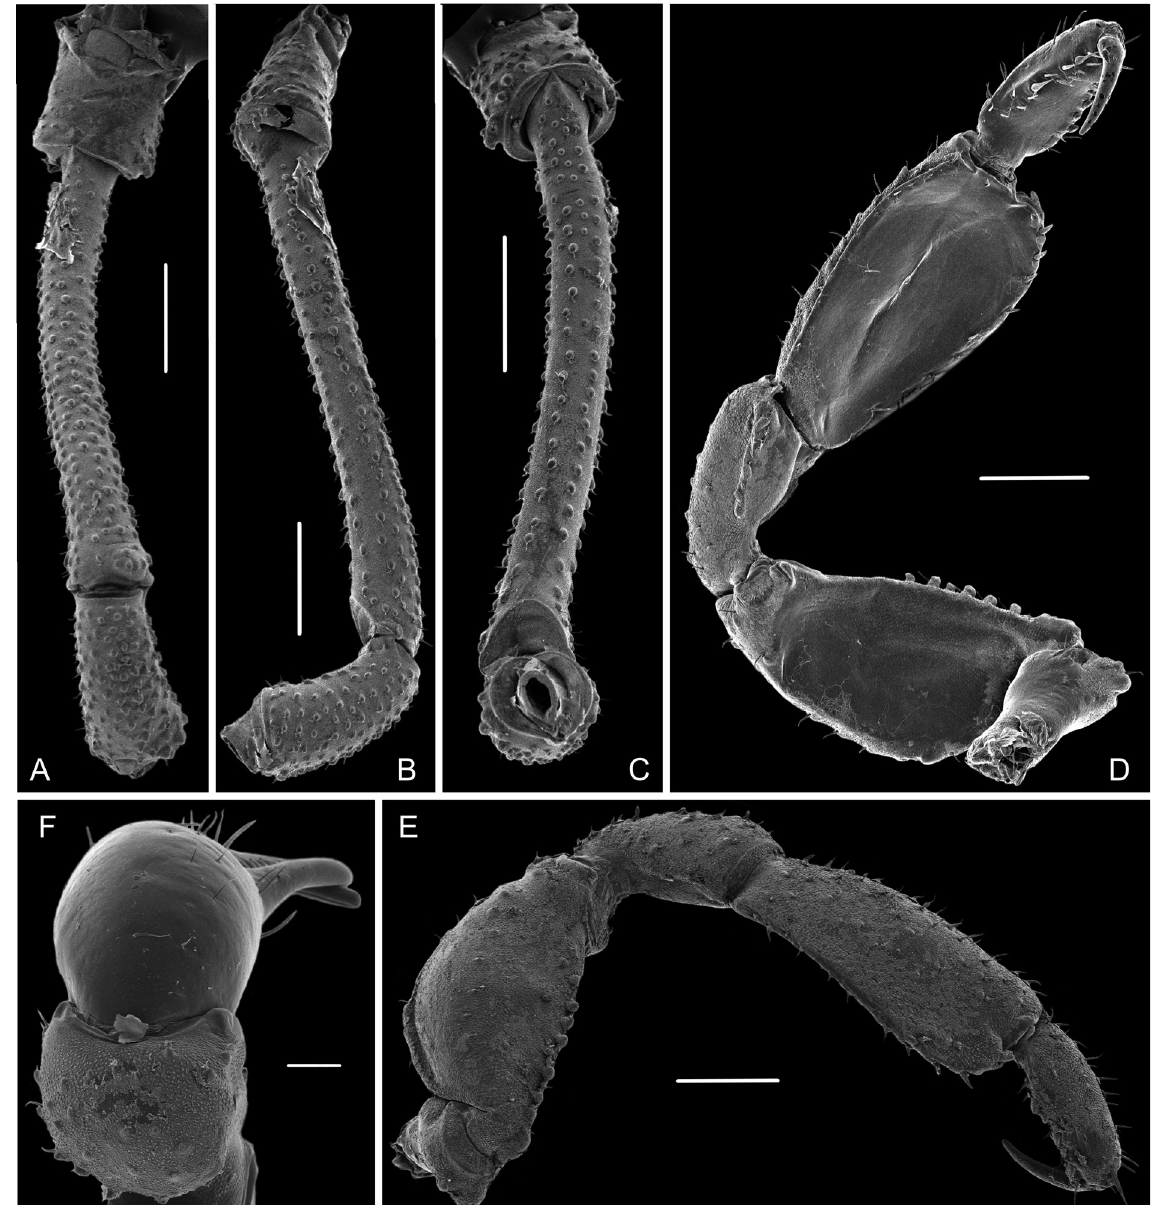
Fig. 21. Eulibitia maculata Roewer, 1912, ♂ (ICN-AO 875). A . Trochanter, femur and patella of leg IV, dorsal view. B . Same, prolateral view. C . Same, ventral view. D . Left pedipalpus, mesal view. E . Same, ectal view. F . Left chelicera, dorsal view. Scale bars: A–C = 1 mm; D–E = 500 µm; F = 200